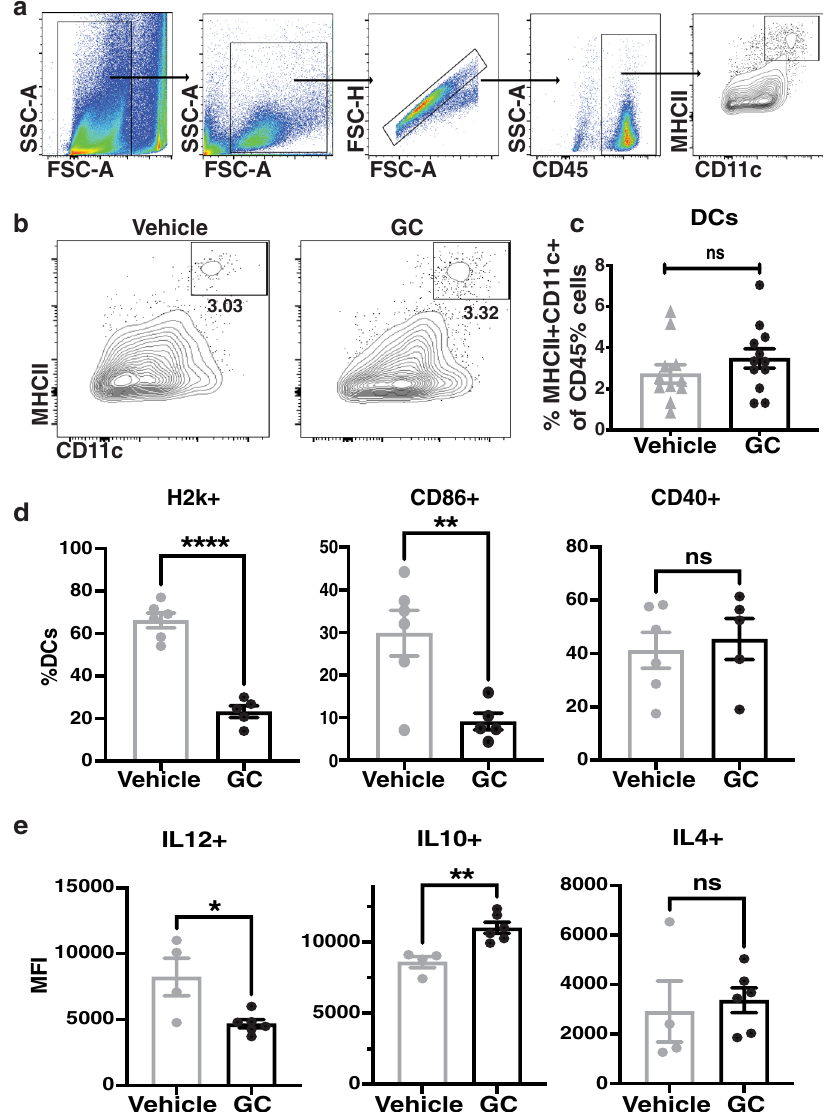
Fig. 3 Gemcitabine-cisplatin chemotherapy attenuates the maturation of immunogenic CD11c + MHCII + dendritic cells. a Flow cytometric gating strategy for dendritic cells from G69-tumor tissues. b, c Flow cytometry plots and corresponding quanti fi cation of CD11c + MHCII + dendritic cells (DC) from vehicle and GC-treated G69-tumor tissues ( n = 11 and n = 12 biologically independent samples respectively). Data are presented as mean values ± SEM. d Relative quanti fi cation (%CD11c + MHC2 + ) of H2-K, CD86, and CD40 expression in tumor-in fi ltrating DCs from vehicle and GC-treated G69-tumor tissues ( n = 6 and n = 5 biologically independent samples, respectively). Data are presented as mean values ± SEM. (Two-tailed, unpaired t -test. **** p < 0.0001, ** p = 0.008). e Mean fl uorescence intensity (MFI) of IL12, IL10, and IL4 expression in CD11c + MHC2 + DCs from vehicle or GC- treated G69-tumor tissues ( n = 4 and n = 6 biologically independent samples, respectively). Data are presented as mean values± SEM.